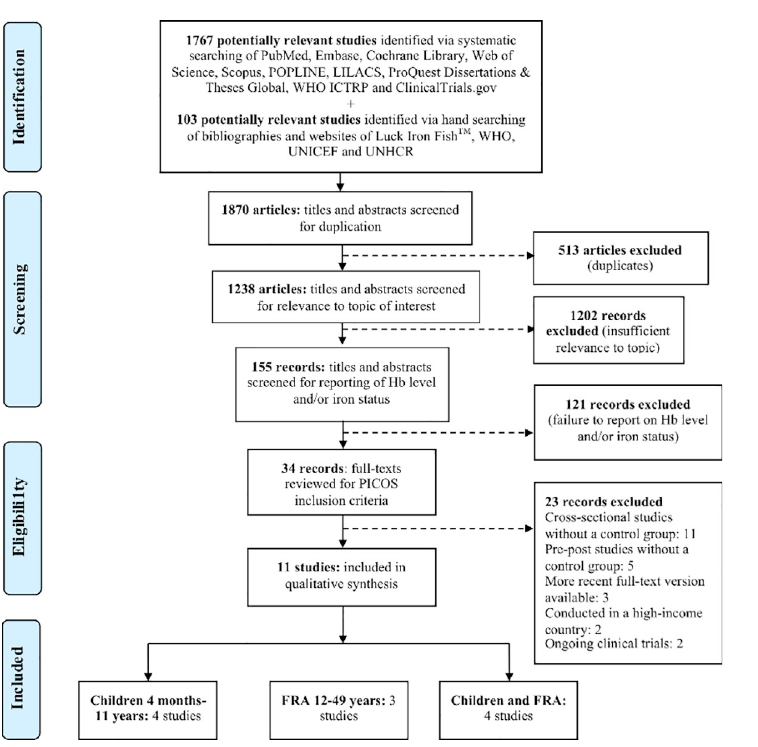
Fig 1. Flow chart of study selection process. FRA: females of reproductive